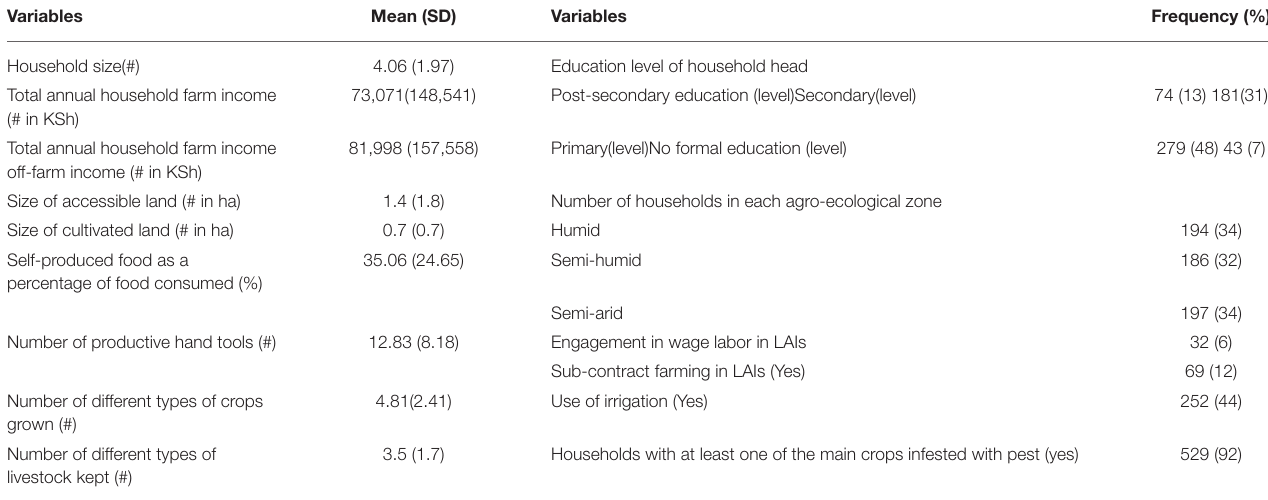
TABLE 3 | Characteristics of the studied households ( n =